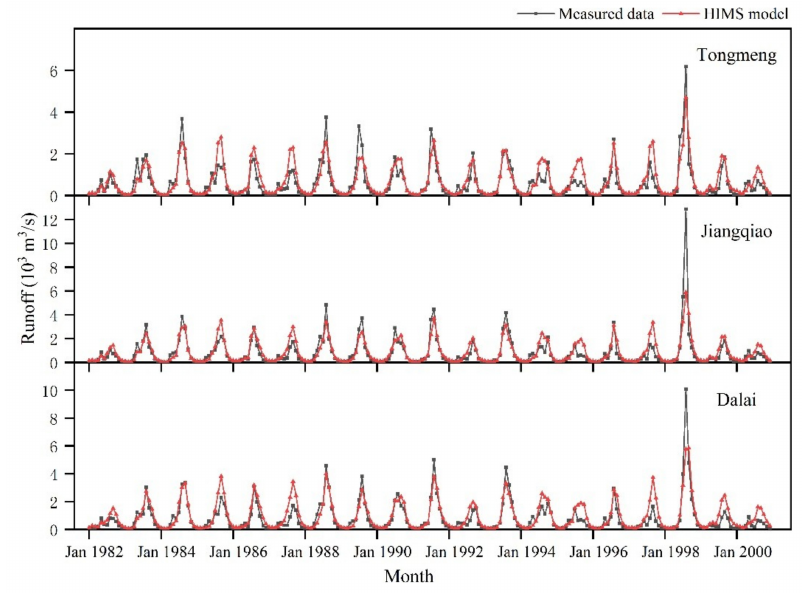
Figure 6. Simulation results of monthly runo ff in the no reservoir operation